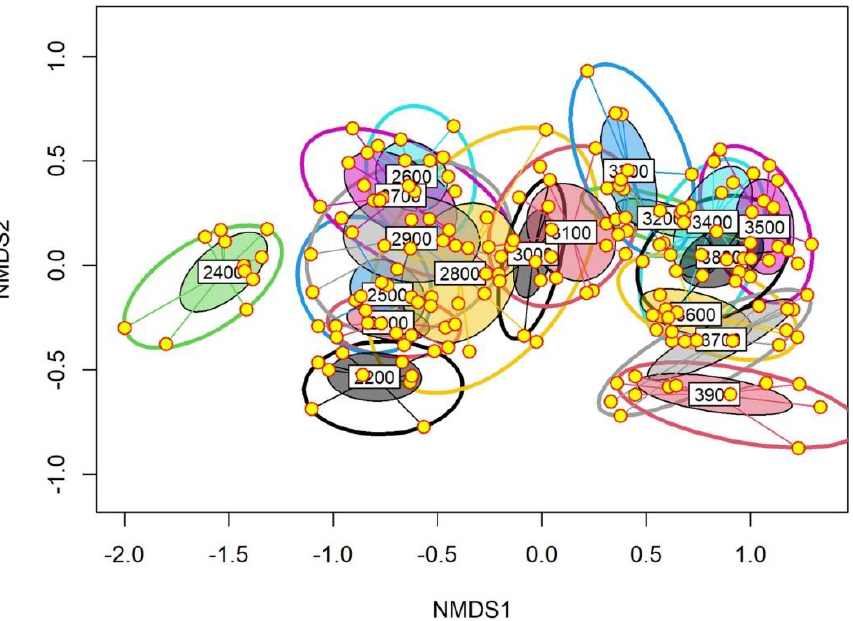
Figure 4. Non-metric dimensional scaling (NMDS) plot showing differences in total plant species composition between the studied 100 m elevation belts. For each ellipse, the size is proportional to within-group dissimilarity or variability, while the degree of overlap between any two ellipses shows the associated community similarity between their respective vegetation.